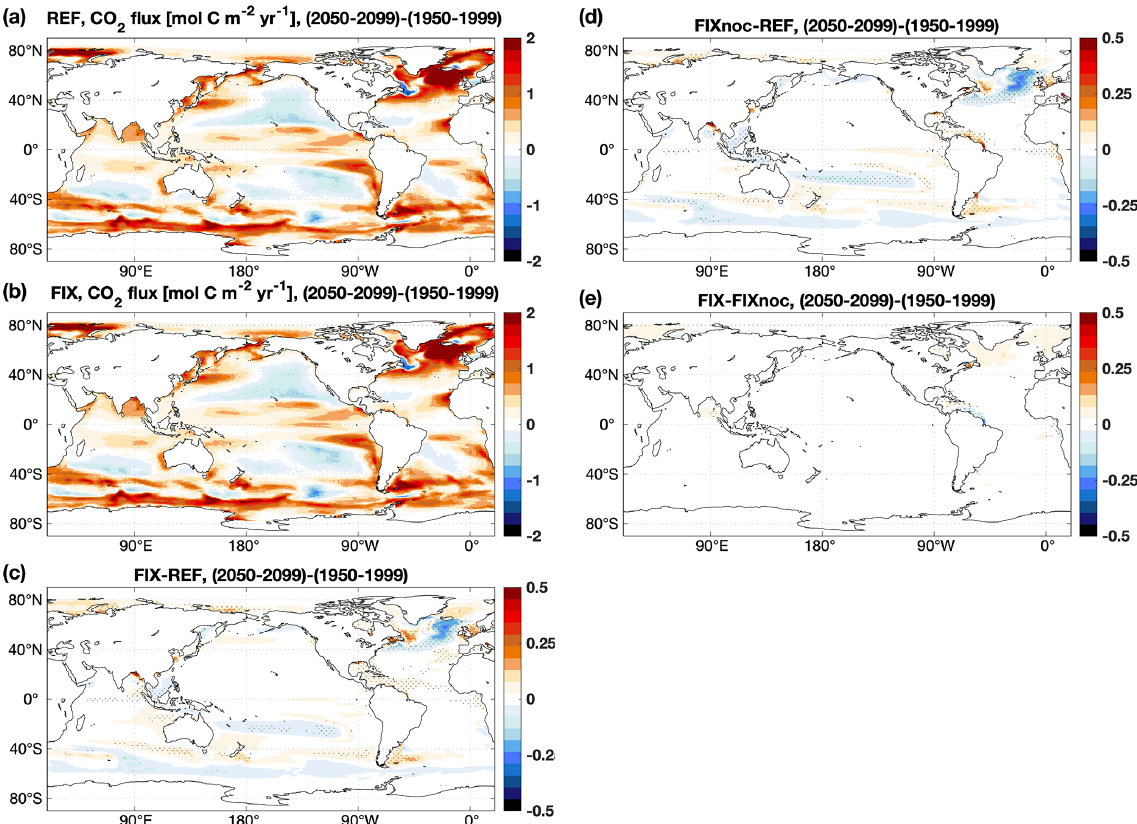
Figure 8. Differences in annual mean air–sea CO 2 fluxes (molCm − 2 yr − 1 ) between the 2050–2099 and the 1950–1999 periods in (a) REF and (b) FIX, (c) the difference between FIX and REF, (d) the difference between FIXnoc and REF, and (e) the difference between FIX and FIXnoc. In panels (c–e) , only significant differences are plotted, and dots denote areas where the signal is larger than the standard deviation of the absolute field (see details in Appendix